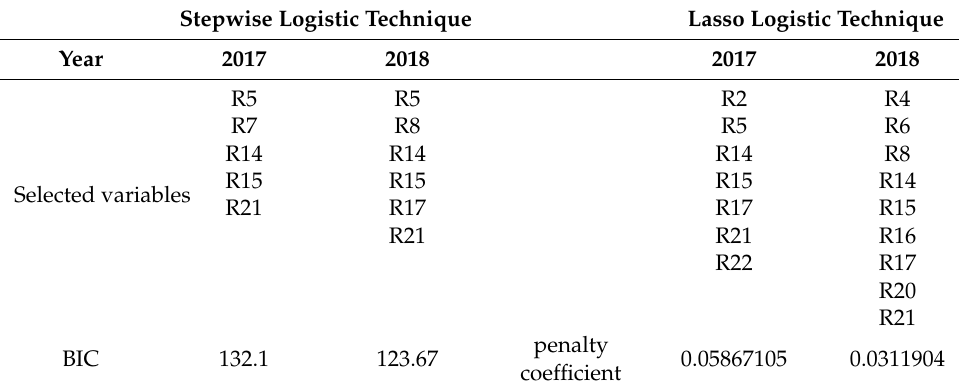
Table 3. Discriminants ratios selected by lasso and stepwise techniques. Stepwise Logistic Technique Lasso Logistic